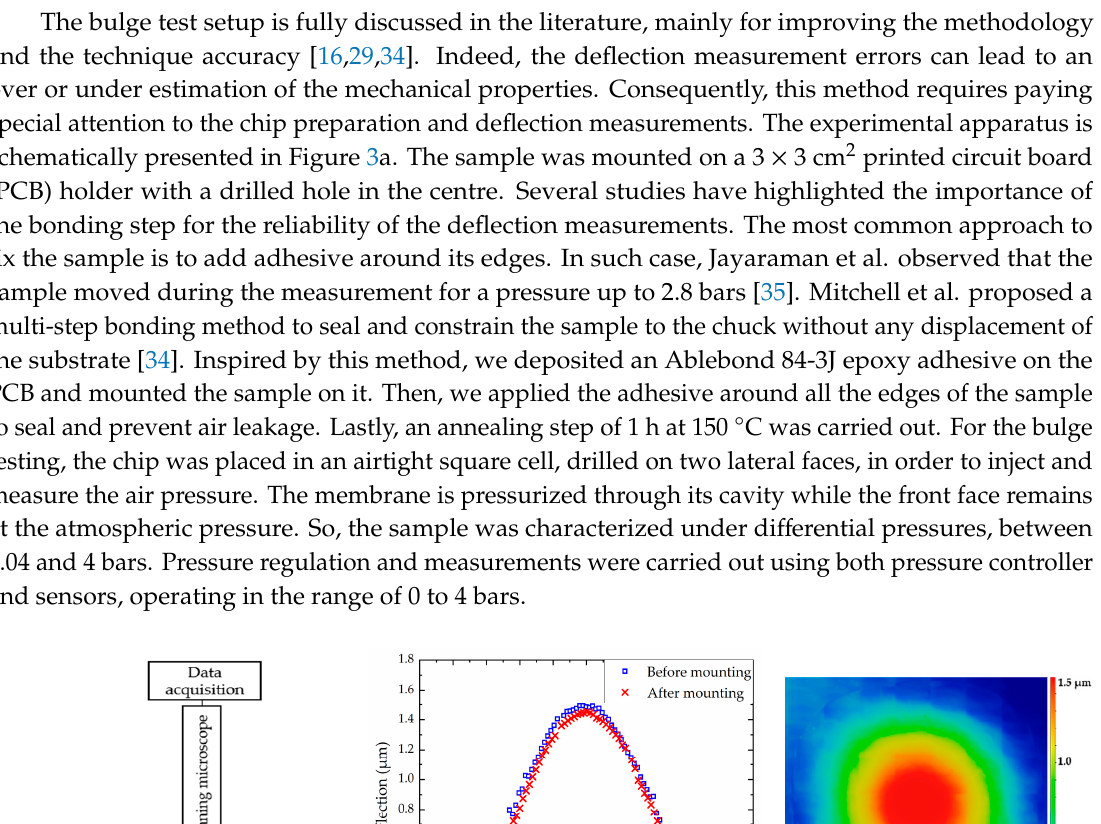
( d ) Figure 4. ( a ) Schematic diagram of the resonance frequency method. Vibration mode shapes measured using laser Doppler vibrometry for ( b ) (1, 1); ( c ) (0, 2); and ( d ) (1, 2) modes. 3. Results and Discussion 3.1. Bulge Test Results As previously explained, the Young’s modulus and the residual stress can be determined using the least square fit of Equation (1). The load-deflection response at the membrane centre h versus P is shown in Figure 5. For the calculations, we fixed the Poisson’s ratio value at 0.25, which is the most common value used in the literature. It has been pointed out by several authors that the influence of υ in the bulge test is negligible [34,37]. Indeed, our calculations confirm that a variation of υ from 0.2 to 0.3 impacts the Young’s modulus value for less than 10%. The parameters used for fitting the data are listed in Table 2.